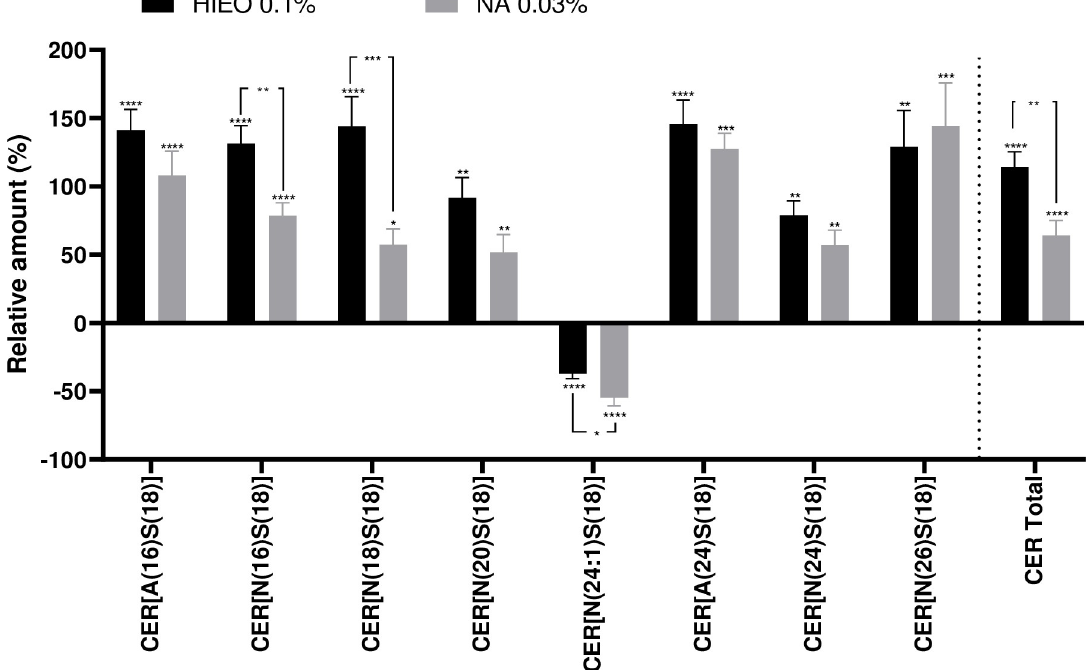
Fig 9. NA increased Ceramides in the epidermis. Ceramides were extracted from epidermis and subjected to LC/MS for determining the levels of each ceramide species. The amount of ceramide species in the HIEO (0.1%) or NA (0.03%) conditions is expressed as a percentage in comparison to the DMSO (0.5%) control condition, which was arbitrarily set (0%). The bar graph representing the relative amount of ceramides is set in %. � p < 0.05; �� p < 0.01; ��� p < 0.001; ���� p < 0.0001 (One-way Anova with post-hoc Tukey HSD test).